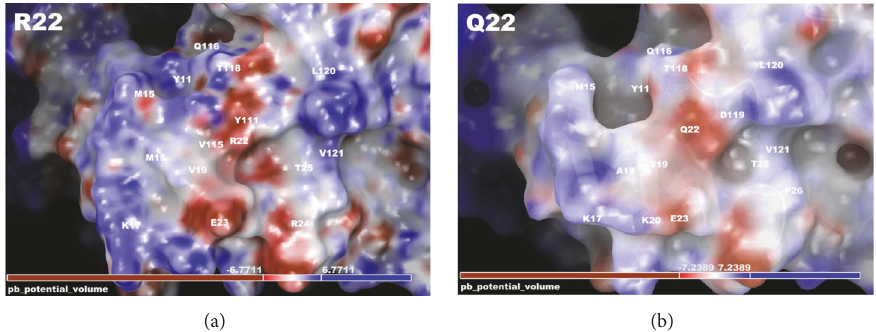
Figure 3: TNFAIP3 electrostatic mapping for interaction potential. Full-length model for the entire TNFAIP3 structure with electrostatics calculated using Poisson-Boltzmann (PB) calculation overlaid onto the structure. The relevant region is zoomed in to show all residues within 12 ˚A of residue position 22. (a) Interacting residues surrounding Arg22 are given with PB electrostatics mapped onto the protein surface. The white label gives the residues’ position. The electrostatic map shows the negative to positive (red to blue) distribution and the contours and shape of the protein in this region. (b) Mutant variant p.R22Q TNFAIP3 model is given with electrostatics overlaid, indicating a muted negative charge. The depiction is similar to that in